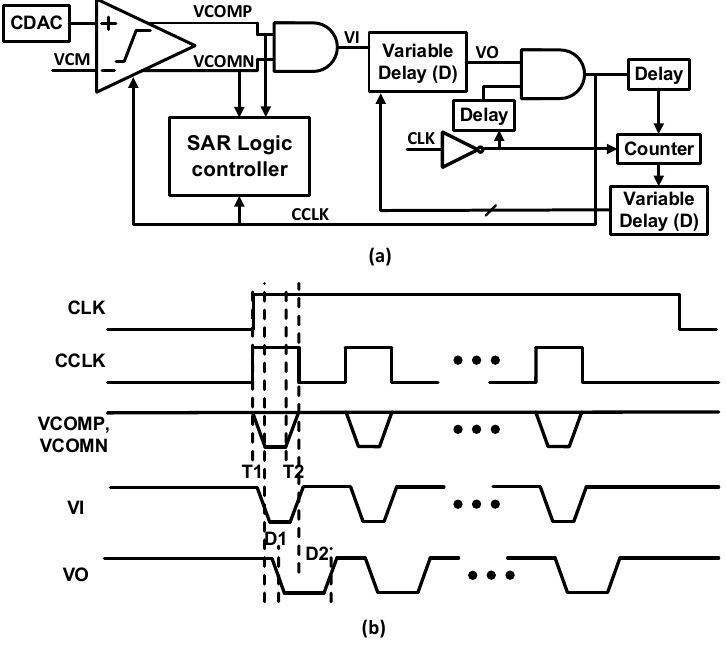
Figure 8. ( a ) Block diagram of the clock generator; ( b ) timing diagram of the clock generator.